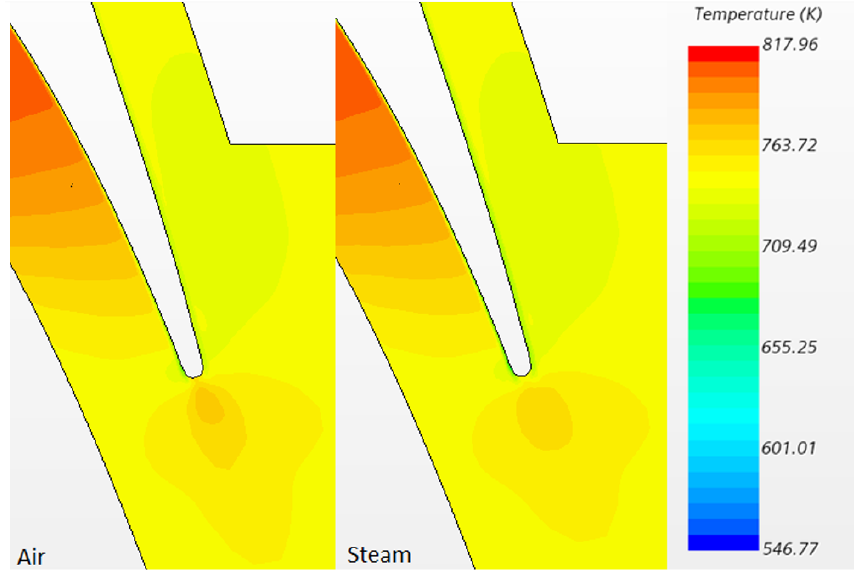
Figure 12. Comparison of the external gas flow temperature near the trailing edge at mid-span.